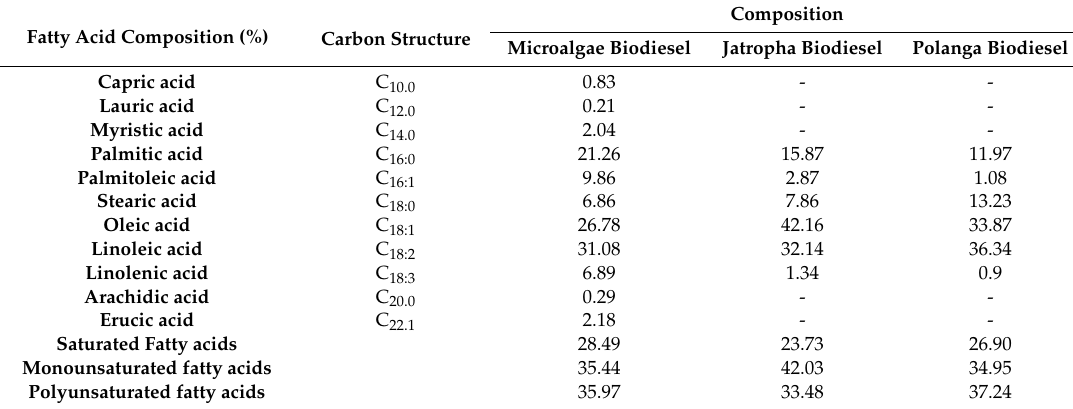
Table 3. Composition of microalgae, jatropha, and polanga